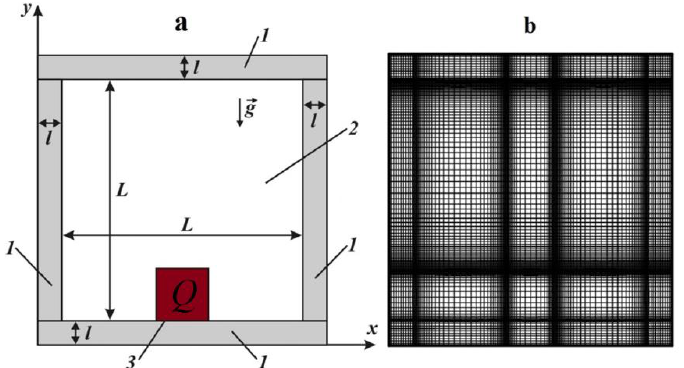
Figure 1. ( a ) A schematic of the system: 1 —solid walls, 2 —air, 3 —heat-generating element; ( b ) computational domain with a non-uniform grid.